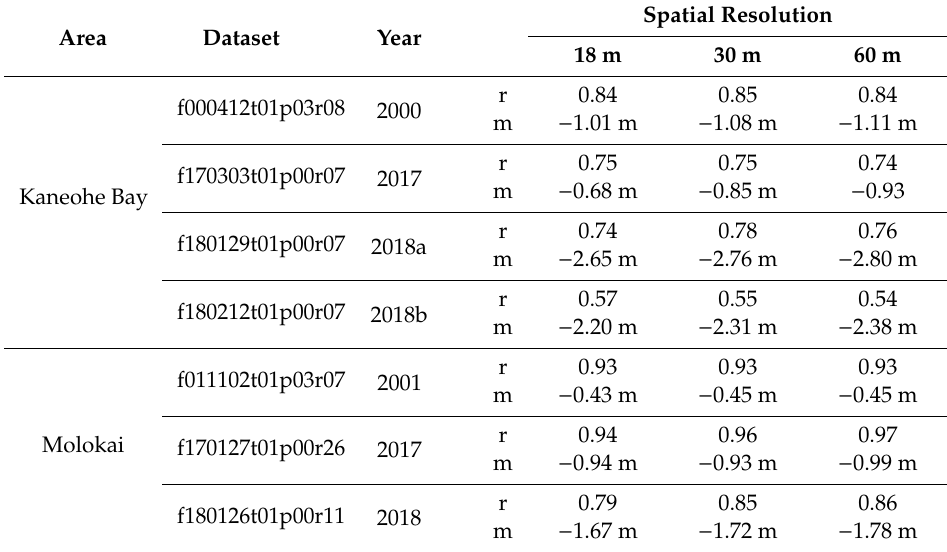
Table 2. Statistical comparison of hyperspectral derived bathymetry compared to lidar bathymetry for Kaneohe Bay and Molokai at different spatial resolutions; with linear correlation coefficient, r, and mean difference, m, for depth range from 0–15 m. Negative m values indicate underestimations of depth by the inversion model. Area Dataset